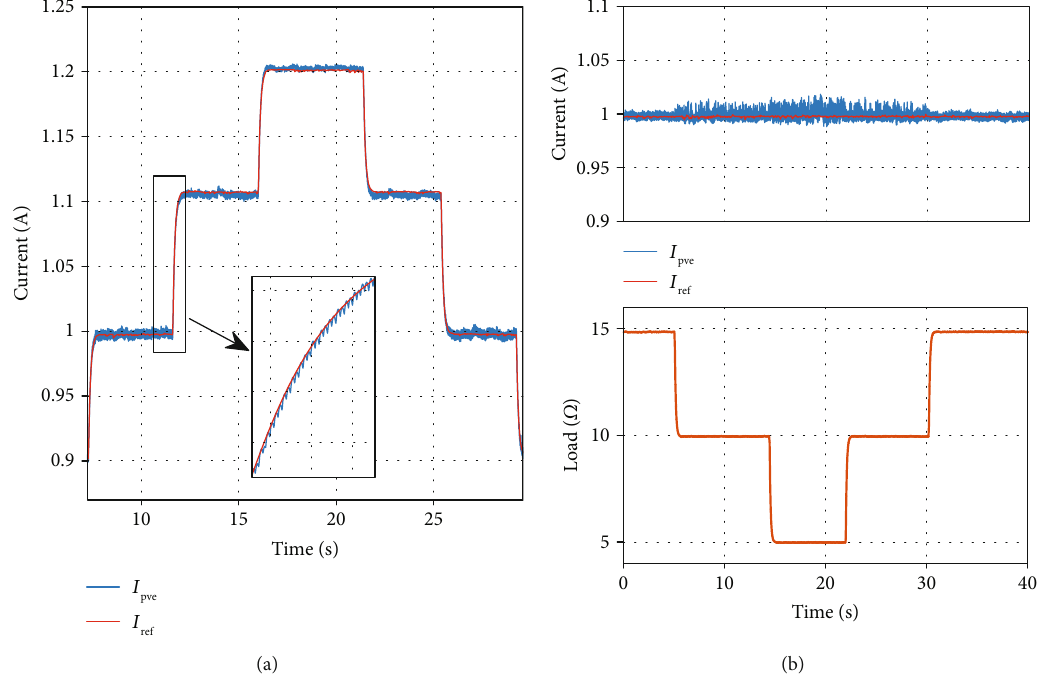
Figure 9: (a) Closed-loop response for abrupt setpoint change, (b) closed-loop response for abrupt load change.